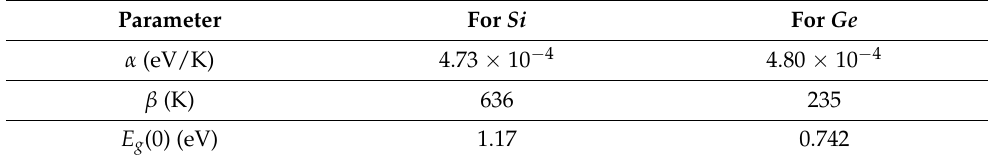
Table 1. Energy bandgap model parameter